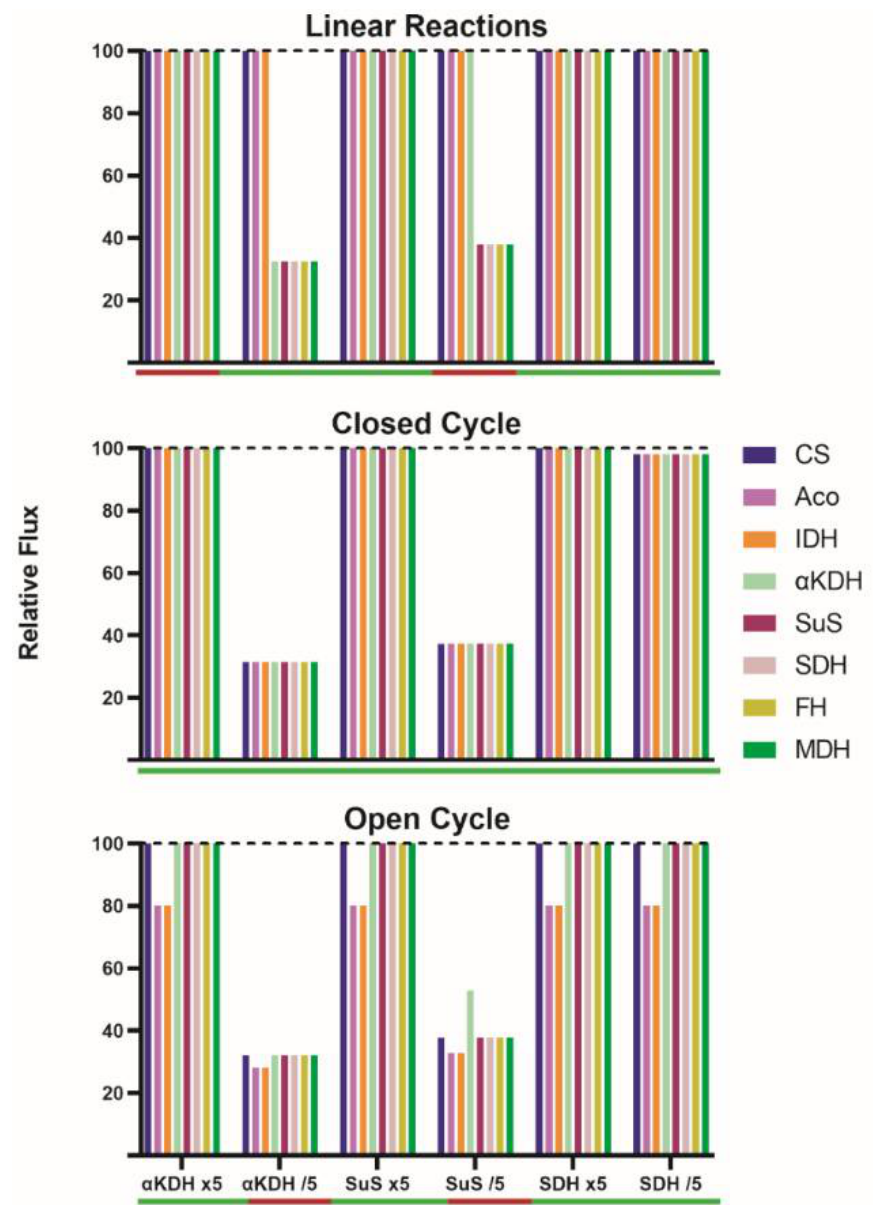
Figure 2. Histograms showing the variation in the relative flux through each TAC step in different conditions. The dotted line indicates the IF of 100 in the initial SS. The red/green horizontal bar under each condition indicates if an SS is reached (green) or not (red). When SS is not reached there are intermediates whose concentrations change with time (See Figure 3 for data derived from considering the closed and open